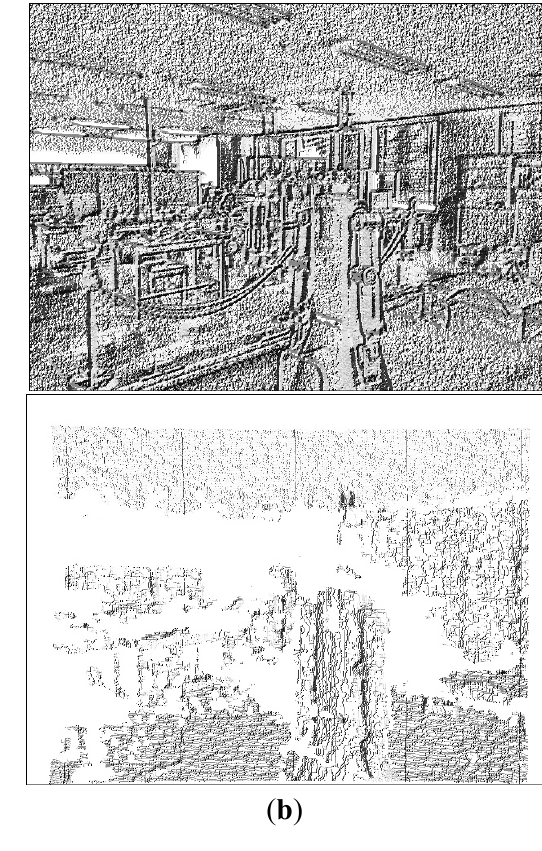
Figure 3. Example LBP transformations. ( a ) Original RGB (upper) and depth (bottom) images; ( b ) Corresponding LBP transformed images: T